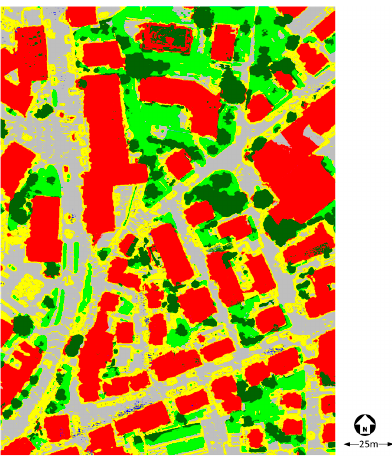
Figure 9. Classification result (red = “building”, dark green = “tree”, green = “low vegetation”, grey = “impervious surface”, yellow = “car”, blue = “clutter”).